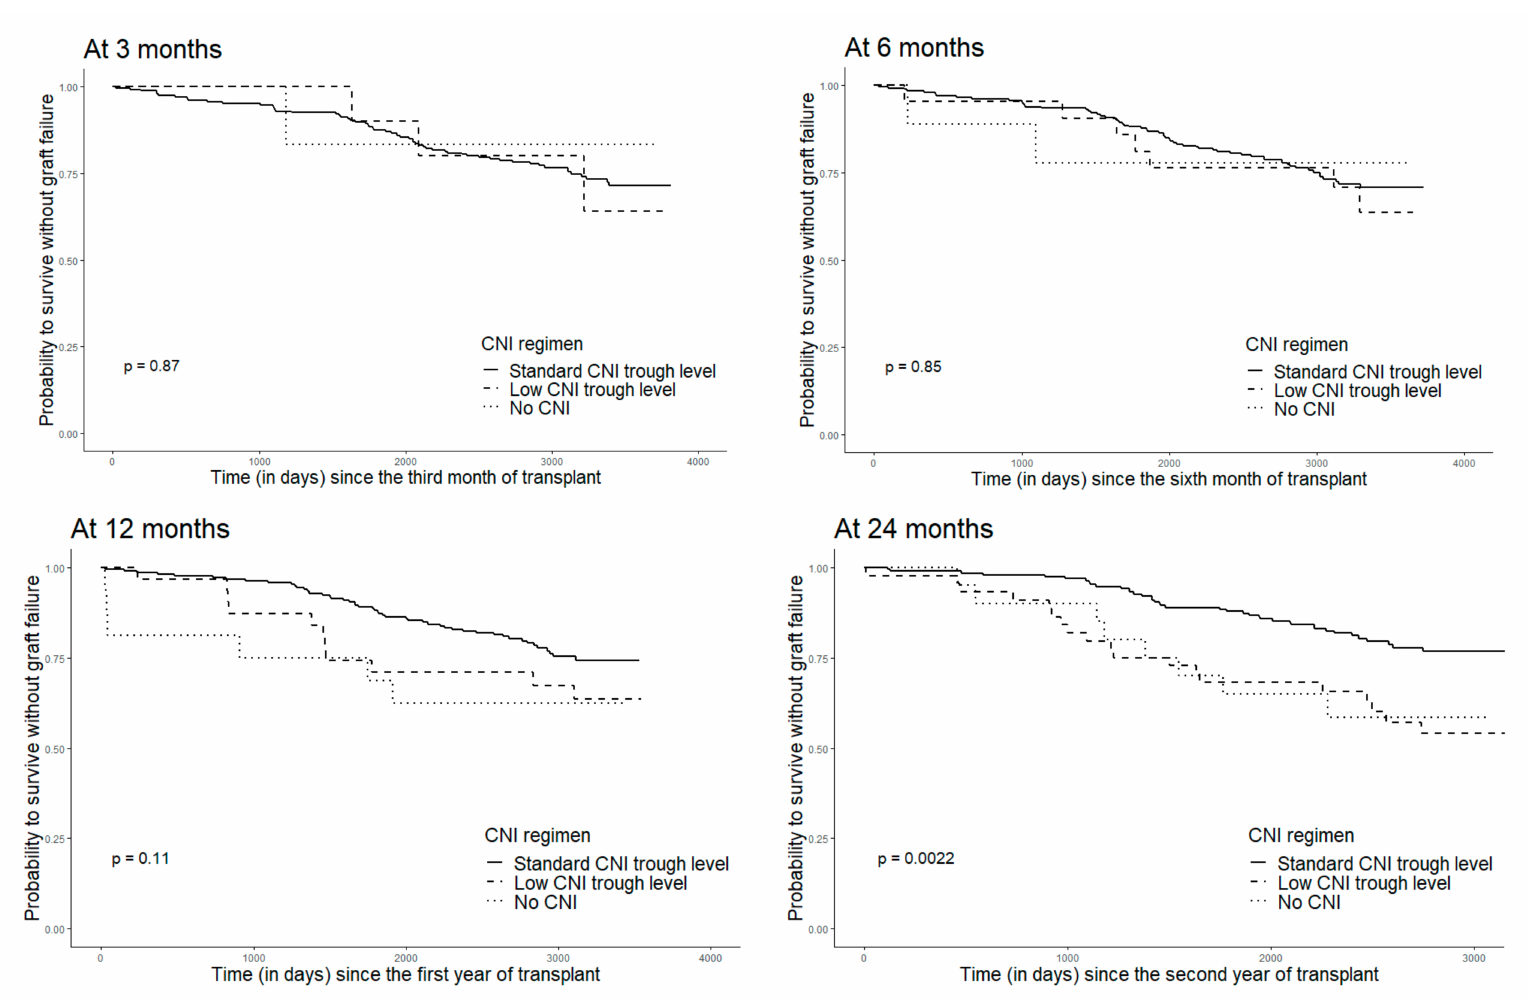
Figure 2. Probability of surviving without graft failure according to the CNI trough level at 3, 6, 12 and 24 months post transplantation (Kaplan–Meier